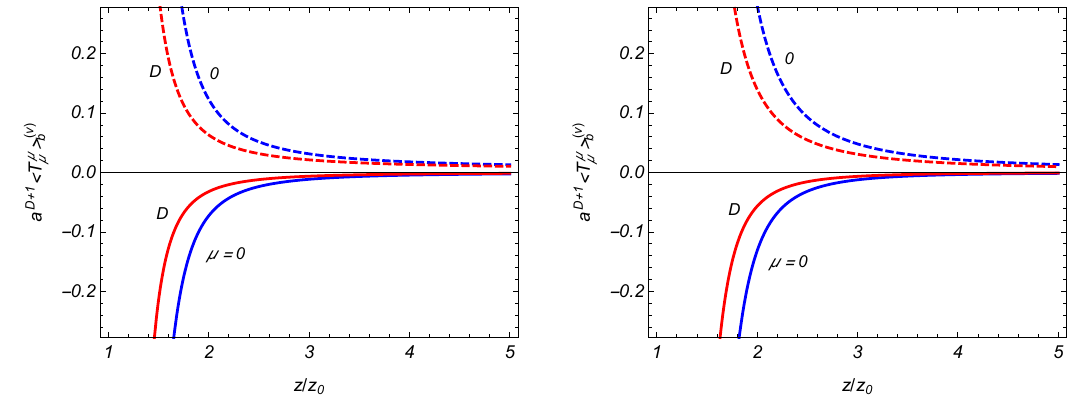
Figure 4. The brane-induced VEVs of the energy density and the normal stress as functions of z / z 0 for: D = 4 electromagnetic field ( left ); and D = 5 electromagnetic field ( right ). The full and dashed curves correspond to the conditions (31) and